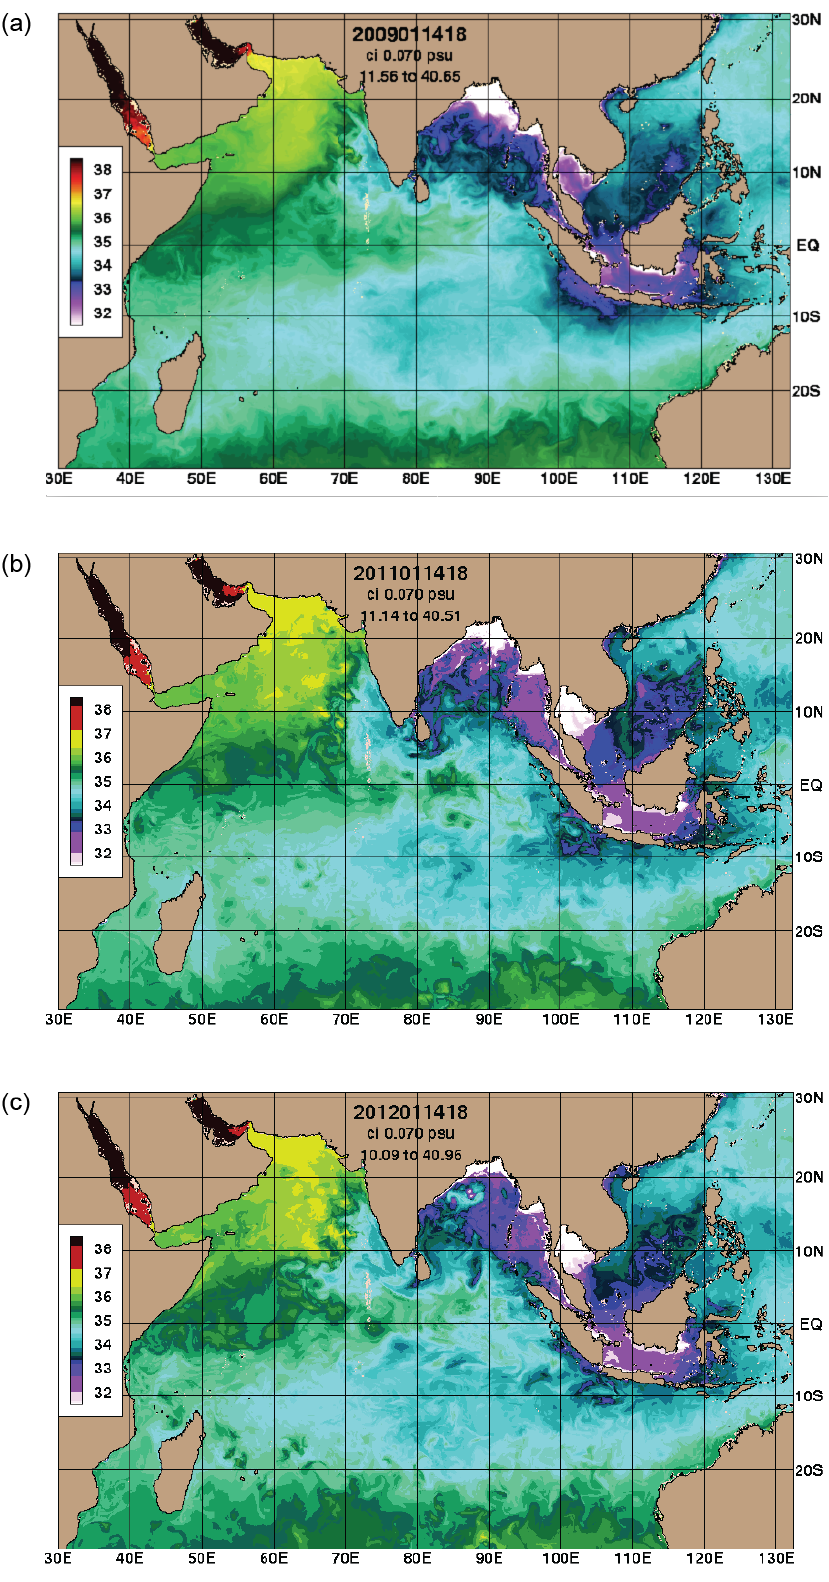
Figure 2. Sea surface salinity in the Indian Ocean from ( a ) 14 January 2009 ( b ) 14 January 2011 and ( c ) 14 January 2012 from HYCOM global hindcast